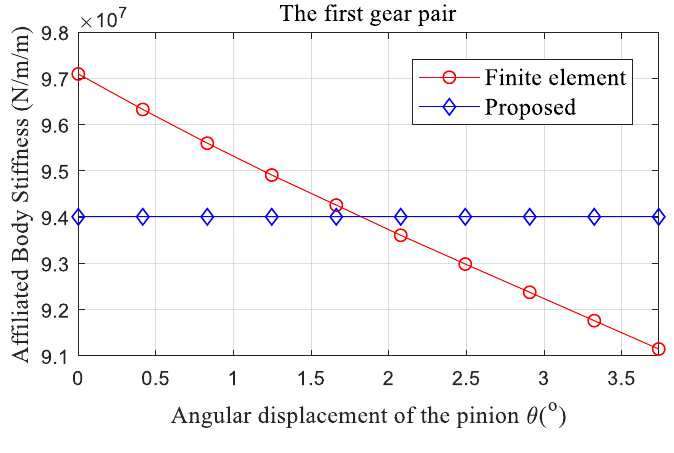
Table 7. Parameters of two standard involute spur gear pairs. Number of Teeth